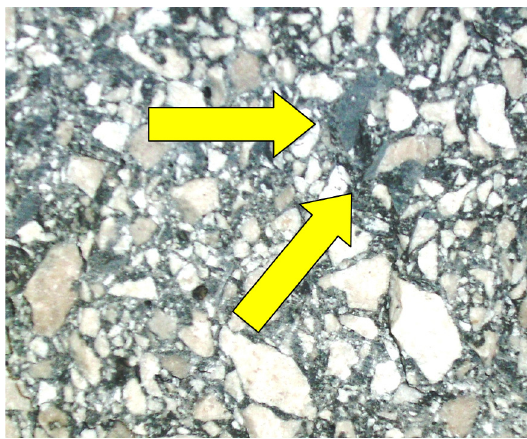
Figure 11. Surface of the VSCC specimen after failure.